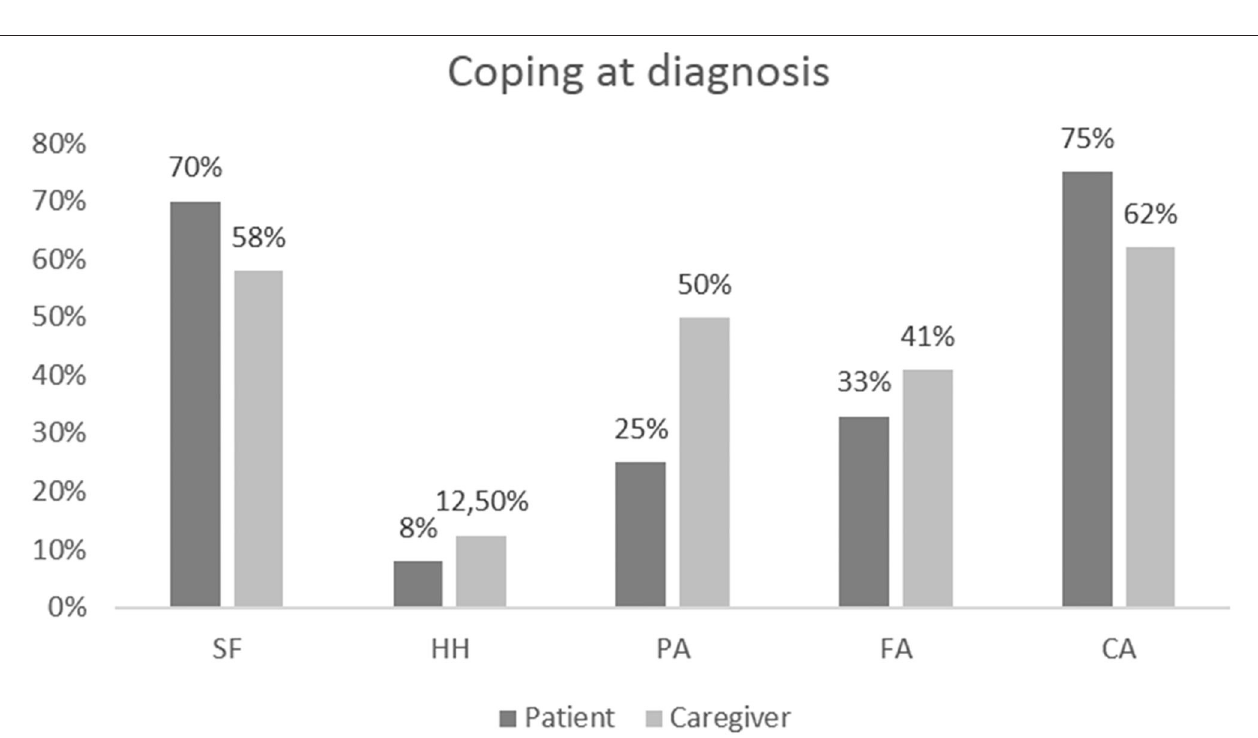
FIGURE 2 | Results of coping assessments at recurrence in patients and caregivers at the individual level.